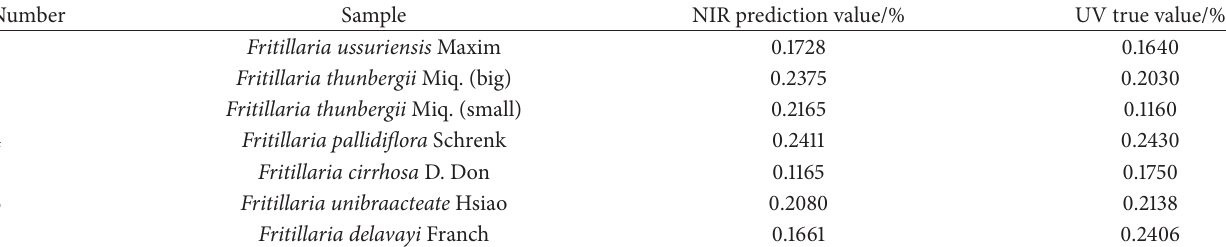
Table 5: Quantitative analysis results for the samples in validation set by PLS model.